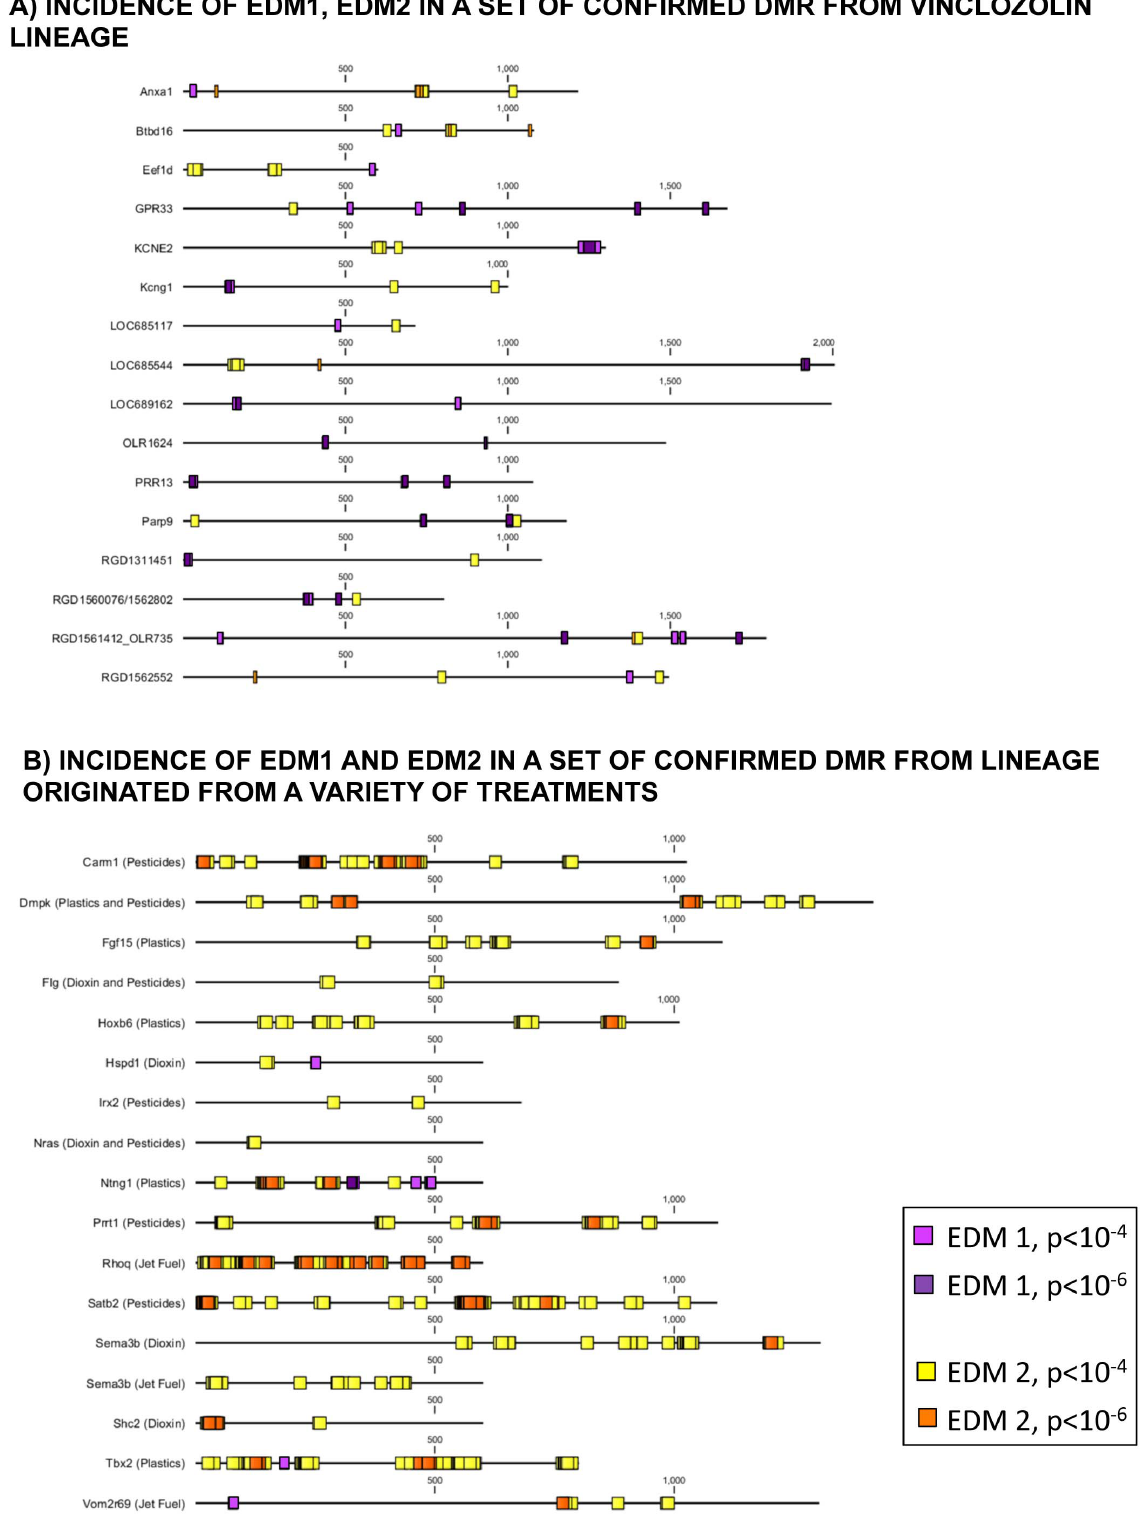
Figure 8. Visualization of DNA motifs associated with epigenetic transgenerational inheritance in selected sets of sequences: (A) incidence of EDM1 and EDM2 in a set of confirmed DMR from vinclozolin-lineage and (B) incidence of EDM1 and EDM2 in a set of confirmed DMR from lineage originated from a variety of exposures listed. The colored legend for EDM1 versus EDM2 motifs are presented.